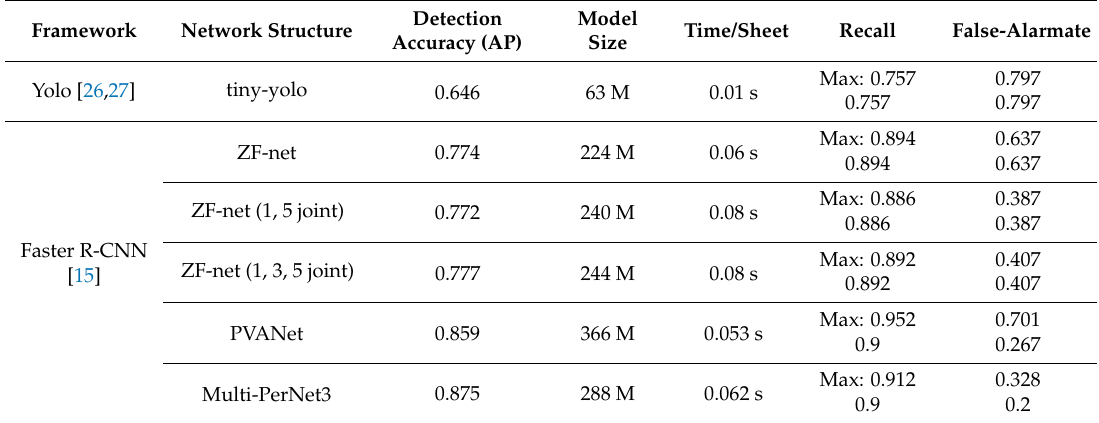
Table 4. Comparison of model results.